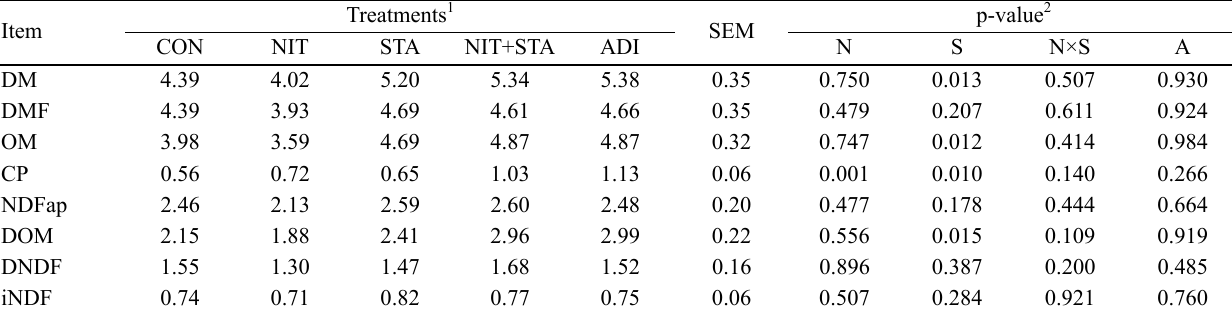
Table 3. Least squares means of intake (kg/d) of dry matter (DM), DM from forage (DMF), organic matter (OM), crude protein